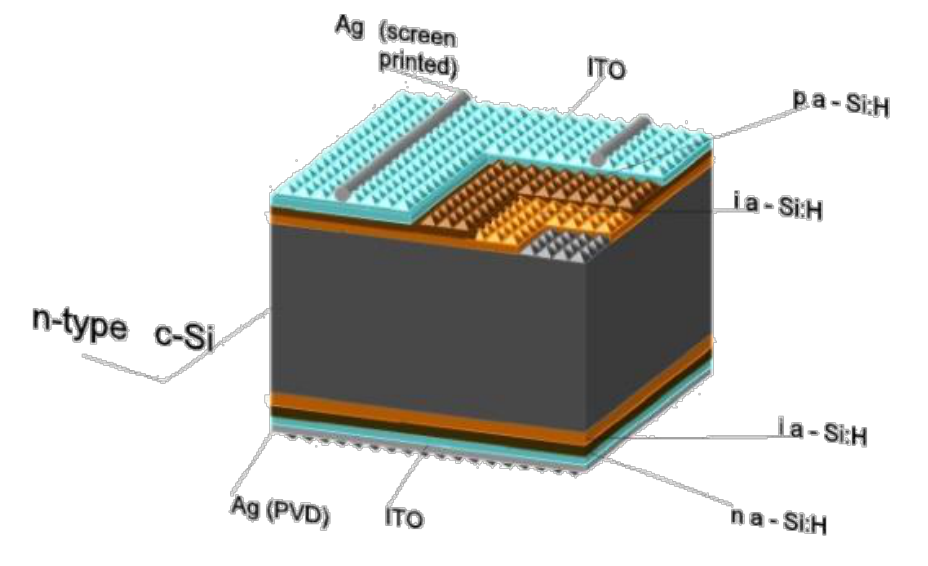
Figure 1. Schematic view of the HJT solar cell